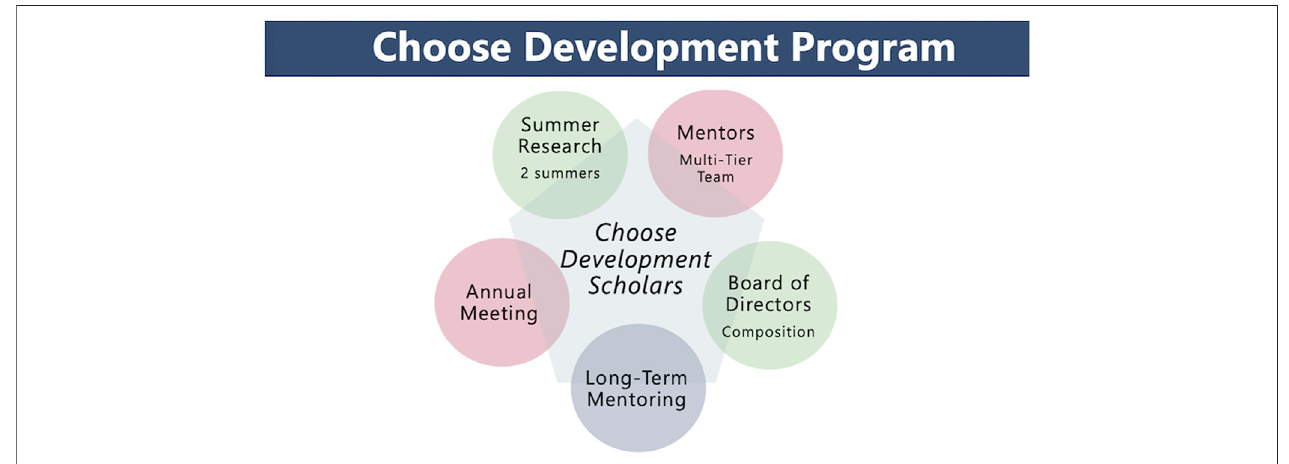
FIGURE 1 | Transformation of the Society for Developmental Biology into a more diverse and inclusive scienti fi c society through a comprehensive research- intensive experience and long-term mentoring of undergraduate students.